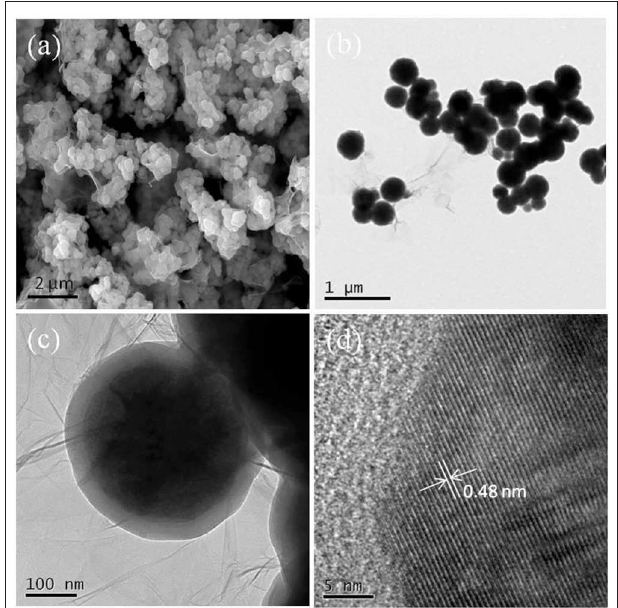
FIGURE 1 | (a) SEM image of Fe 3 O 4 @GO-e, (b) TEM image of Fe 3 O 4 @GO-e, (c) magnified TEM image of (b) , and (d) high-resolution TEM image of Fe 3 O 4 @GO-e.